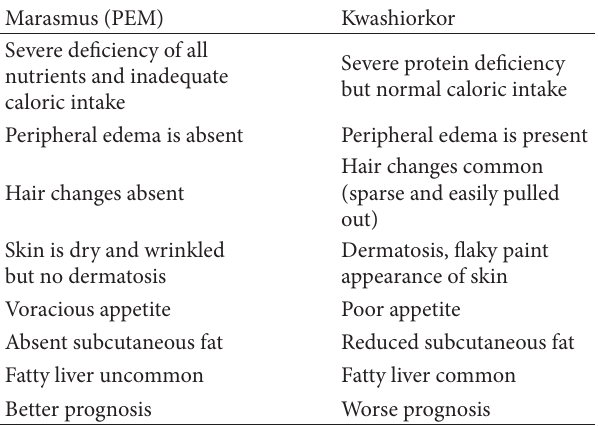
Table 1: A comparison between marasmus and